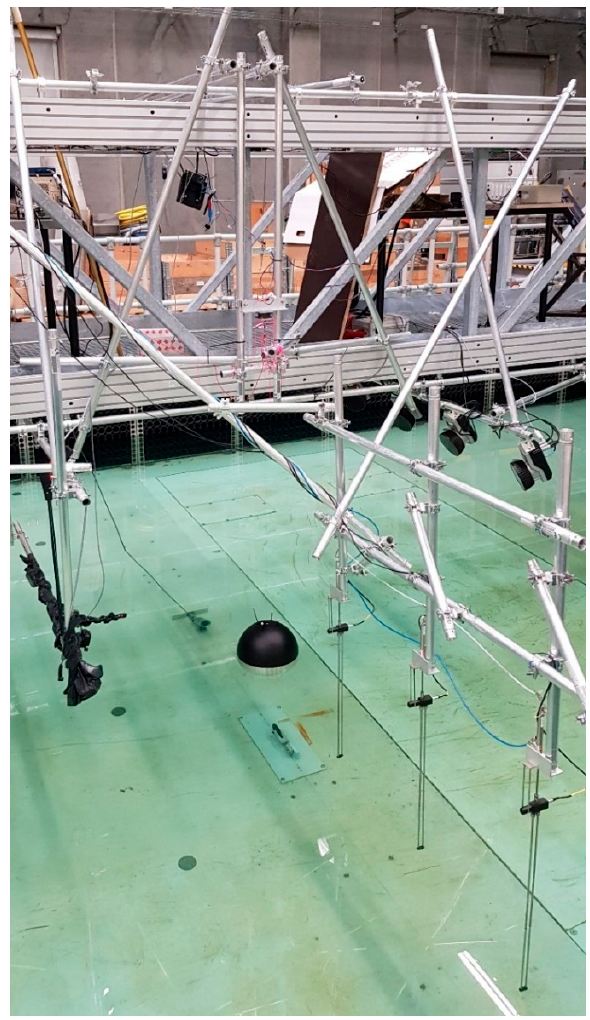
Figure 9. Test setup in the wave basin: center—half-submerged sphere model; left—camera; front—wave gauges; right—motion capture cameras; above—release system fixed to the bridge.